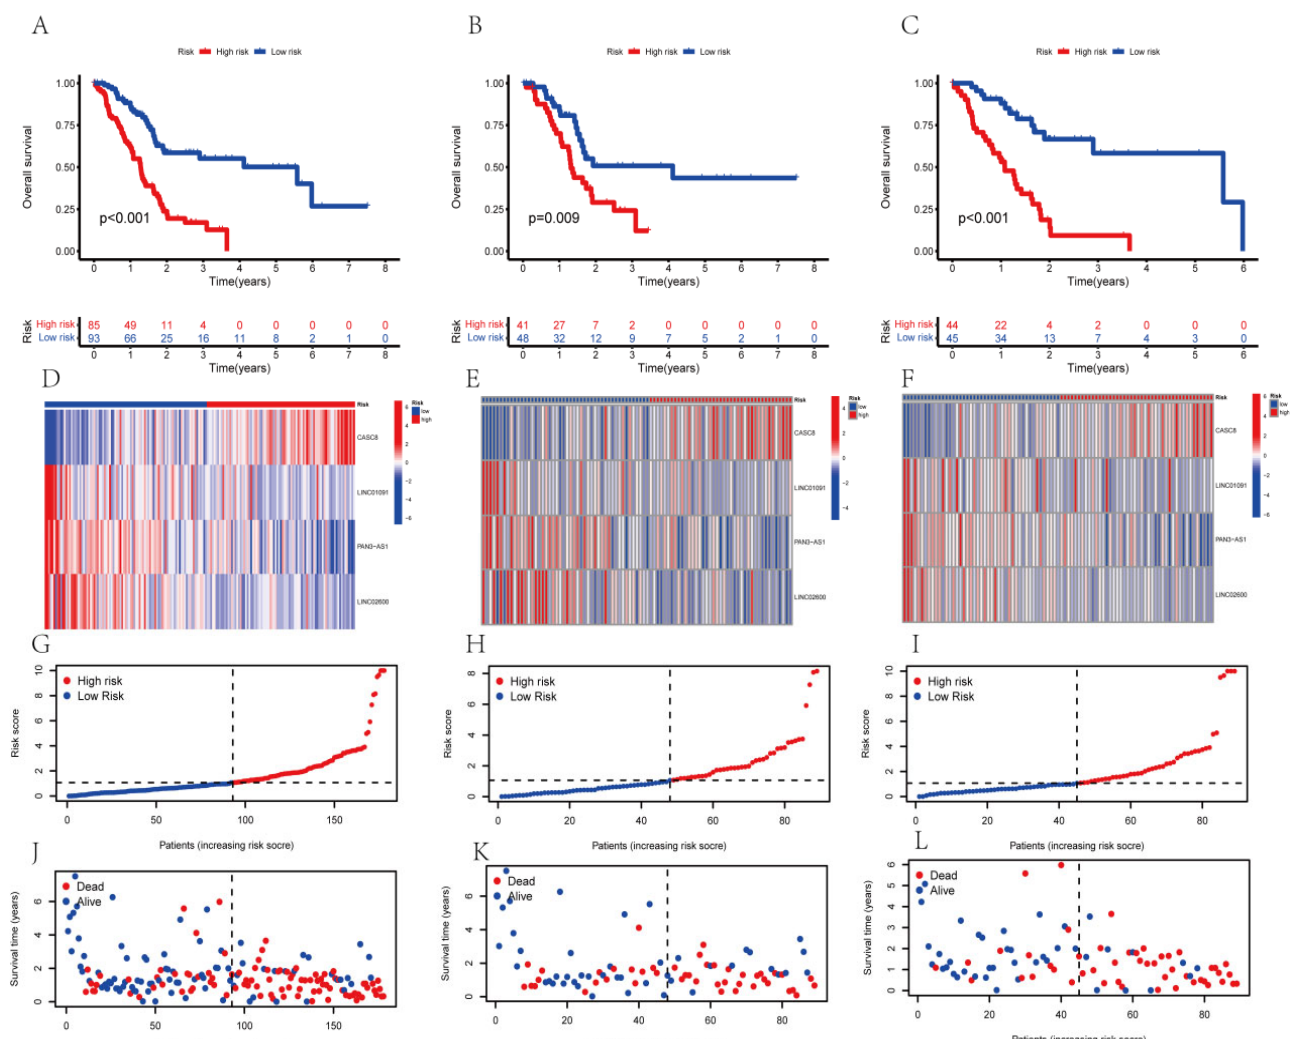
Figure 3. The KM curves of the risk model in the all ‐ data group, training group, and test group. ( A – C ) The OS curves of the high ‐ risk and low ‐ risk patients in different groups. ( D – F ) The heat map of the expression of the four lncRNAs. ( G – I ) The distribution of the risk scores of PAAD patients. ( J – L ) The distribution of the survival time and survival status of PAAD patients in the low ‐ risk and high ‐ risk groups.